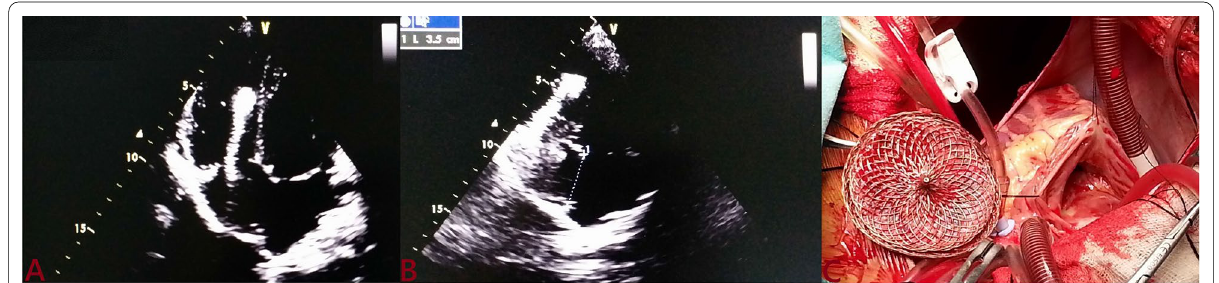
Fig. 10 Dislodged device into right ventricle ( A ) in a patient with very large defect ( B ) who underwent surgery ( C dislodged